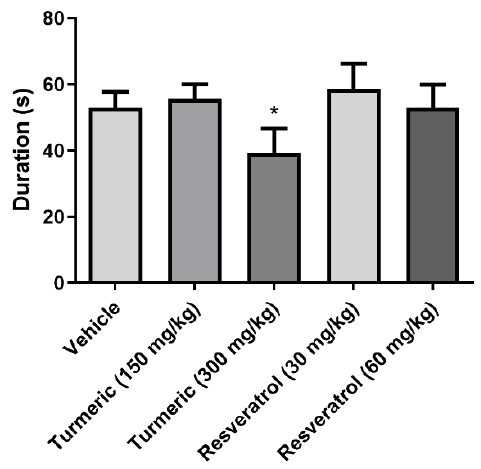
Figure 3. Duration of the first generalized seizure. The 300 mg/kg of turmeric group decreased the duration of the first generalized seizure compared to the vehicle group. Data were analyzed by one-way ANOVA one-way, followed by Tukey’s multiple comparison test. Data are expressed as the mean ± standard error. * p < 0.05 vs. the vehicle group.